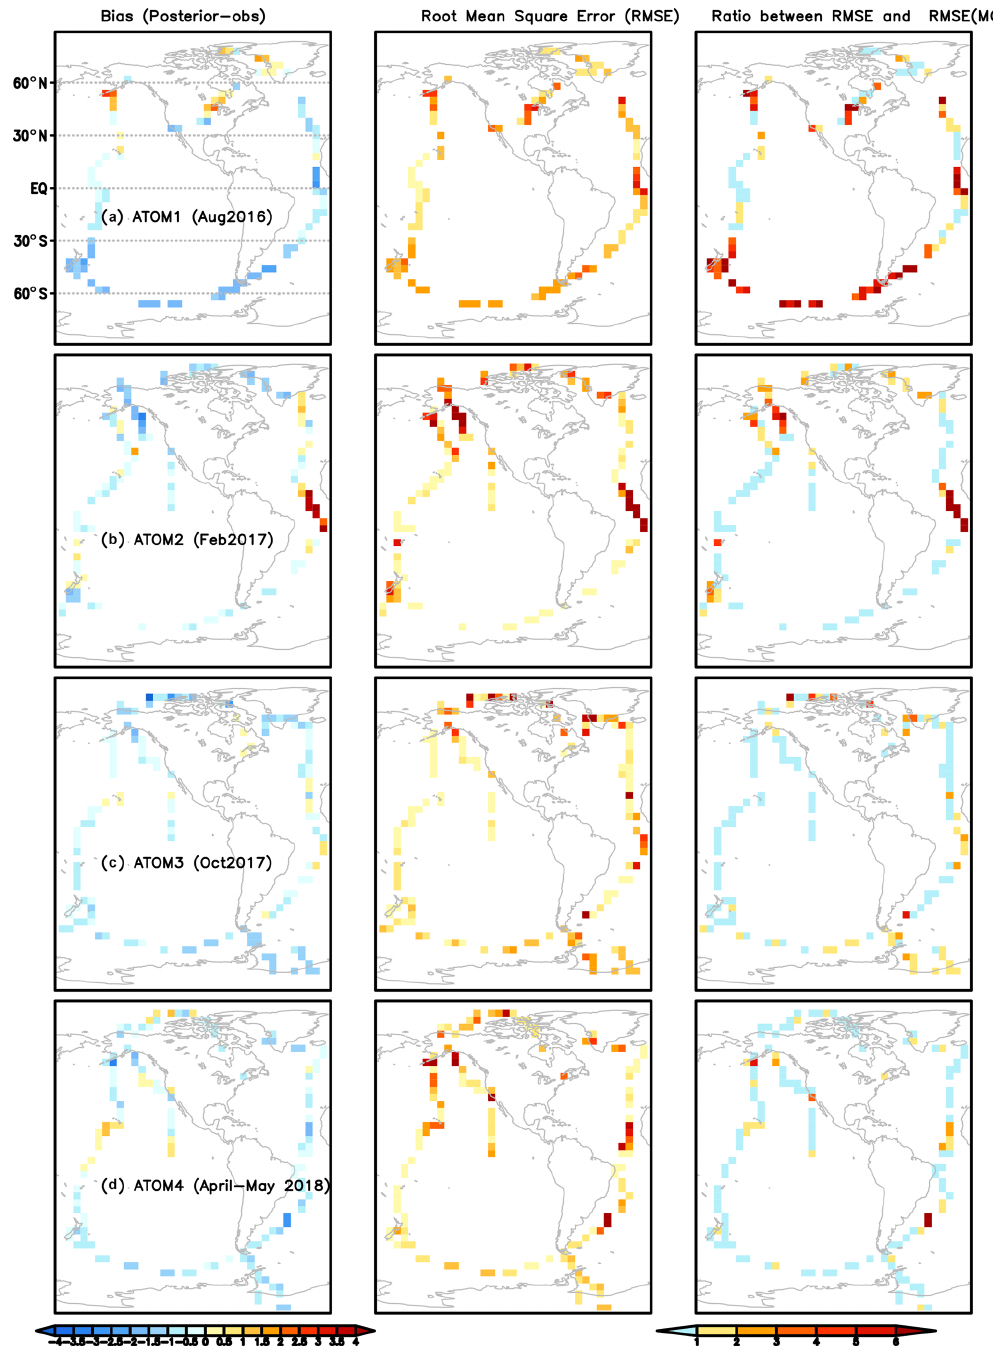
Figure 10. Left column: the mean differences between posterior CO 2 and aircraft observations from ATom 1–4 aircraft campaigns between 1–5km (a–d) . Middle column: the root mean square errors (RMSEs) between aircraft observations and posterior CO 2 between 1–5km. The color bar is the same as in the left column. Right column: the ratio between RMSE and RMSE MC based on ensemble CO 2 from the Monte Carlo uncertainty estimation